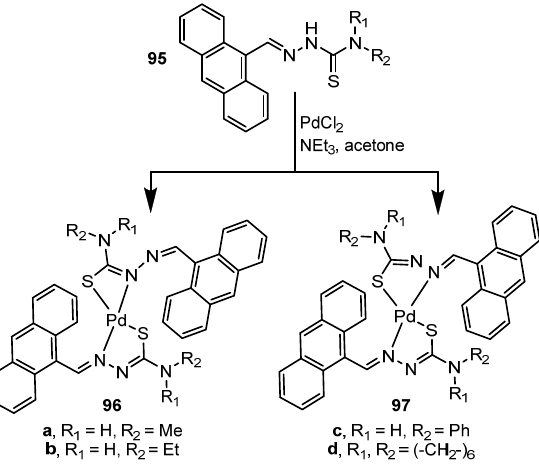
Figure 27. Synthesis of Pd(II) thiosemicarbazones 95–97 bearing anthracene. Adapted from [98].